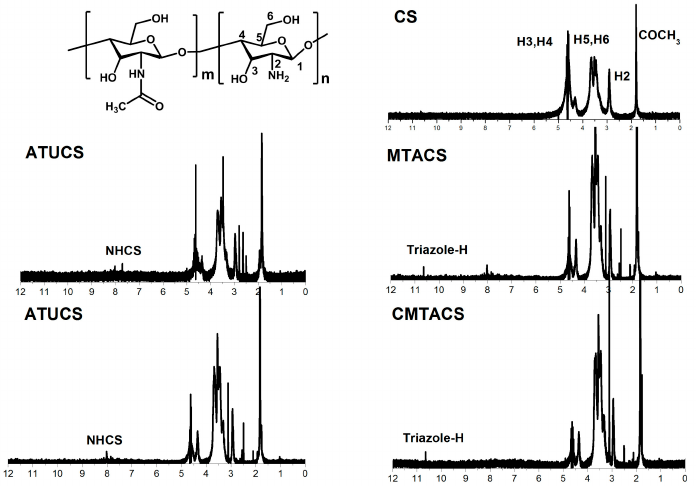
Figure 2. 1 H-NMR spectra of chitosan (CS), acetyl thiourea chitosan (ATUCS), 3-methyl-1,2,4-triazolyl chitosan (MTACS), chloracetyl thiourea chitosan (CATUCS), and 3-chloromethyl-1,2,4-triazolyl chitosan (CMTACS) derivative.